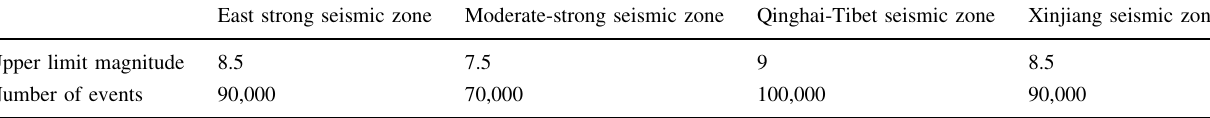
Table 2 Number of seismic events in each seismic zone